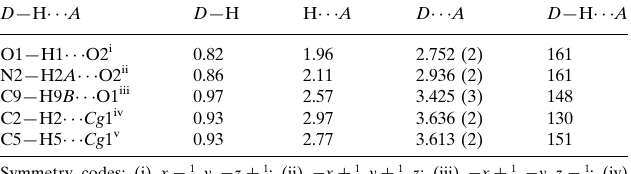
dihedral angle benzene